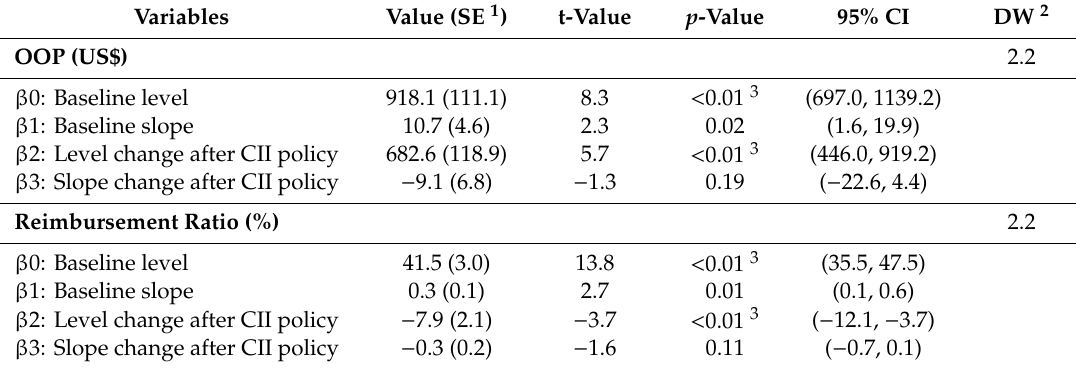
Table 3. Interrupted time series (ITS) analysis results of policy e ff ect on OOP expenses and reimbursement ratio (RR) in